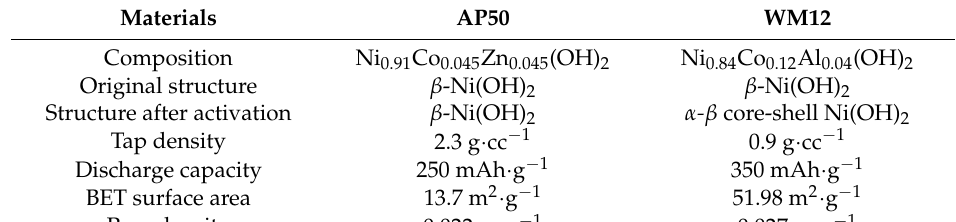
Table 3. Various properties of AP50 and WM12.